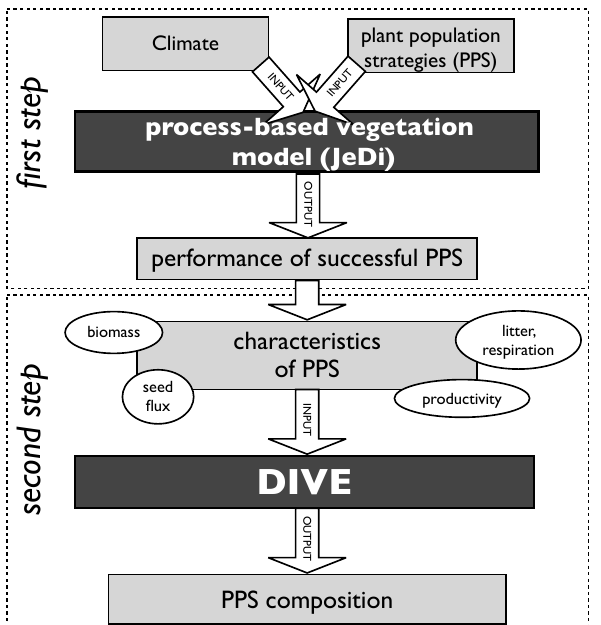
Table 1. Model variables and parameters used in